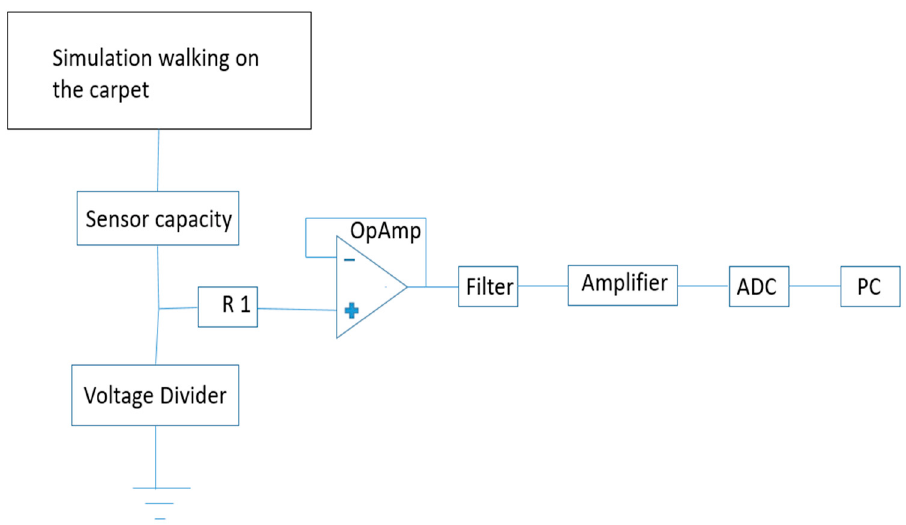
Figure 4. Schematic diagram of the new electrostatic characterization set up.